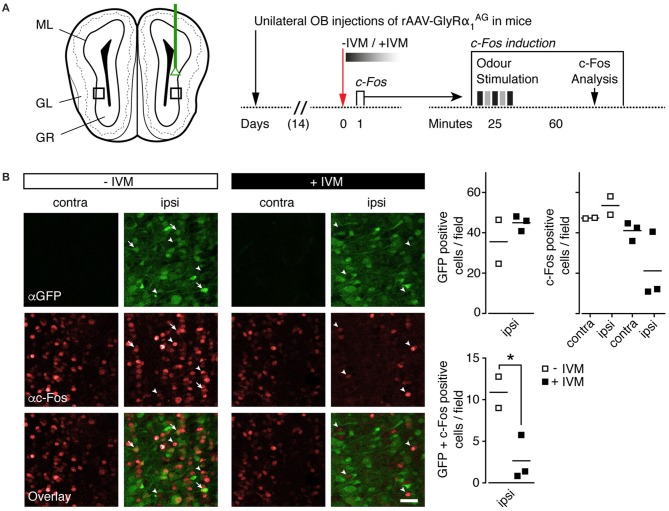
IVM induced GlyRα1AG activation lead to a decrease in odor induced c-Fos expression in the olfactory bulb. (A) Left: Scheme of unilateral stereotactic OB injection of rAAV-syn-GlyRα1AG-2A-Venus. Black squares indicate approximate size and position of fields shown in (B). ML, mitral/tufted cell layer; GL, glomerular layer; GR, granule cell layer. Right: Time line of the experiment; the c-Fos induction protocol used 1 day after IVM injection is shown on the right. (B) Left: Fields of 150 × 150 μm were evaluated for c-Fos (αc-Fos, red) and Venus (αGFP, green) expression. Without IVM injection (−IVM), the number of c-Fos immunoreactive cells was comparable on contra- and ipsilateral sides; after the injection of IVM (+IVM), the number of c-Fos immunoreactive cells and the number of GFP and c-Fos double labeled cells decreased steeply on the ipsilateral side (arrow tips: c-Fos only labeled cells, whole arrows: GFP/c-Fos double positive cells); scale bar: 30 μm. Right: Quantification of GFP and c-Fos positive cells (top row) and GFP/c-Fos double positive cells (bottom row), numbers per 150 × 150 μm; horizontal line indicates mean; GlyRα1AG +IVM, n = 3; GlyRα1AG −IVM, n = 2; *p < 0.05.